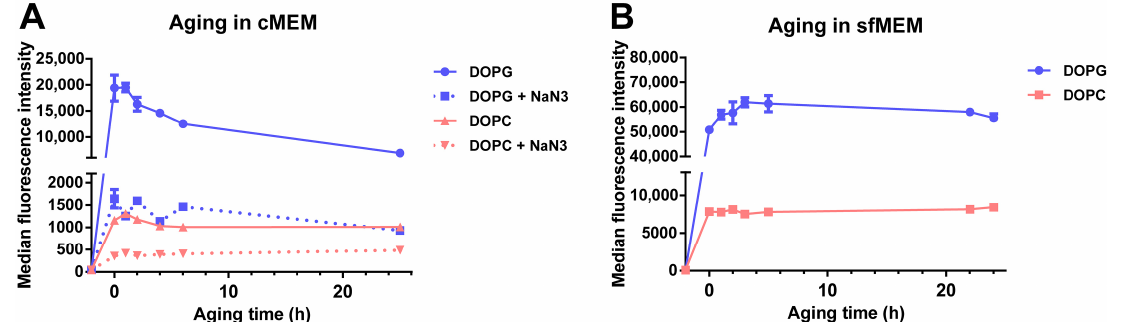
Figure 5. Cellular uptake of liposomes after aging in cMEM or serum free medium (sfMEM). ( A–B ) Cellular uptake of DOPG and DOPC liposomes in cMEM in the presence or absence of NaN 3 ( A ) and liposomes in sfMEM ( B ). Briefly, 62 µg/ml DOPG or DOPC liposomes in cMEM ( A ) or sfMEM ( B ) were maintained in cell culture conditions in a humidified atmosphere with 5% CO 2 at 37 °C for increasing times (aging). Then after different aging times, the dispersion was collected and added to cells for 2 h, prior to quantification of cell fluorescence by flow cytometry. For liposomes in cMEM, uptake experiments were performed in the presence or absence of 5 mg/ml NaN 3 (see Methods for details). The results are the average and standard deviation over 2 replicates of the median cell fluorescence obtained by flow cytometry.